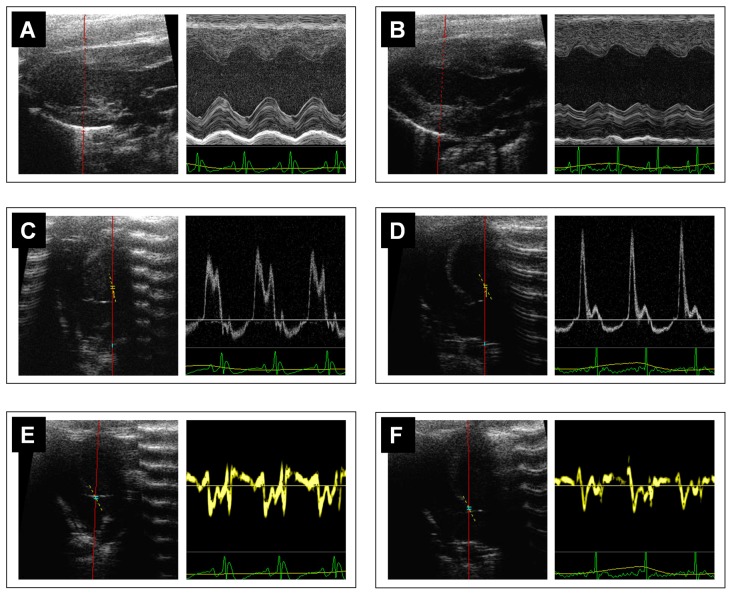
Representative echocardiographic images of control and pressure overloaded rats at 6 weeks after aortic banding.B-mode and M-mode assessments of LV morphology and systolic function in control (A) and pressure overload rats (B). Four chamber view and transmitral Doppler pattern in control (C) and pressure overloaded rats (D). Four chamber view and tissue Doppler spectrum in control (E) and pressure overloaded rats (F).